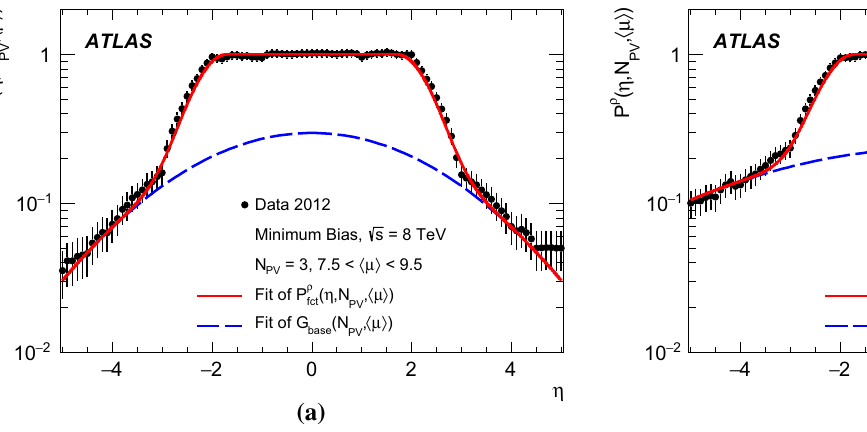
Fig. 1 The average transverse momentum density shape P ρ (η, N PV , (cid:4) μ (cid:5) ) for jets in data is compared to the model in Eq. (9) with (cid:4) μ (cid:5) = 7.5–9.5 and with a three reconstructed vertices and b G base ( N PV , (cid:4) μ (cid:5) ) ( blue dashed line )